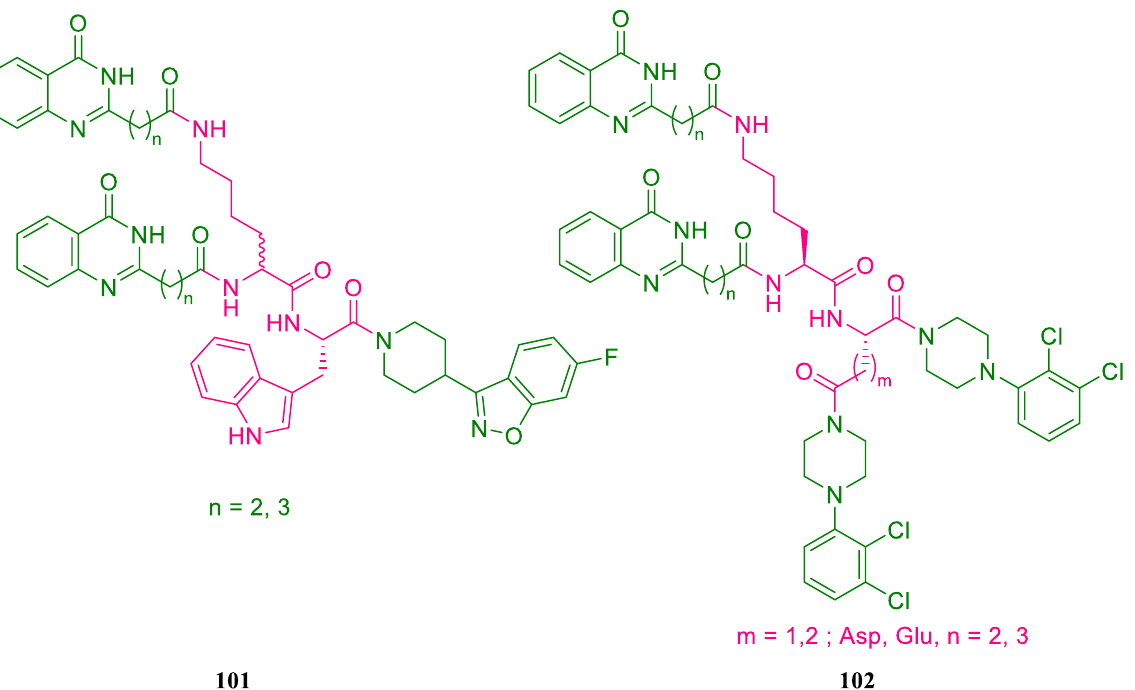
Figure 82. Amino acids conjugated to piperazine, benzisoxazole and quinazolinone derivatives. Kumara H K et al. developed a new class of anionic amino acids (Glu and Asp) linked bis -hydrazones of quinazolinones ( 103 ) by the conjugation of heterocycle with p .TsOH.NH 2 -Asp(OBzl) and HCl.NH 2 -Glu(OCH 3 )-OCH 3 , followed by hydrazinolysis,